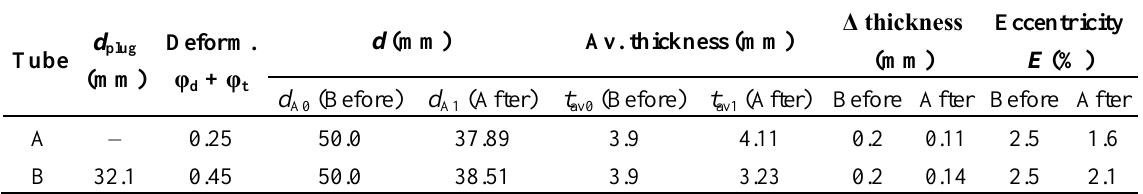
Table 1. Forming parameters used for drawn SF-Cu tubes.